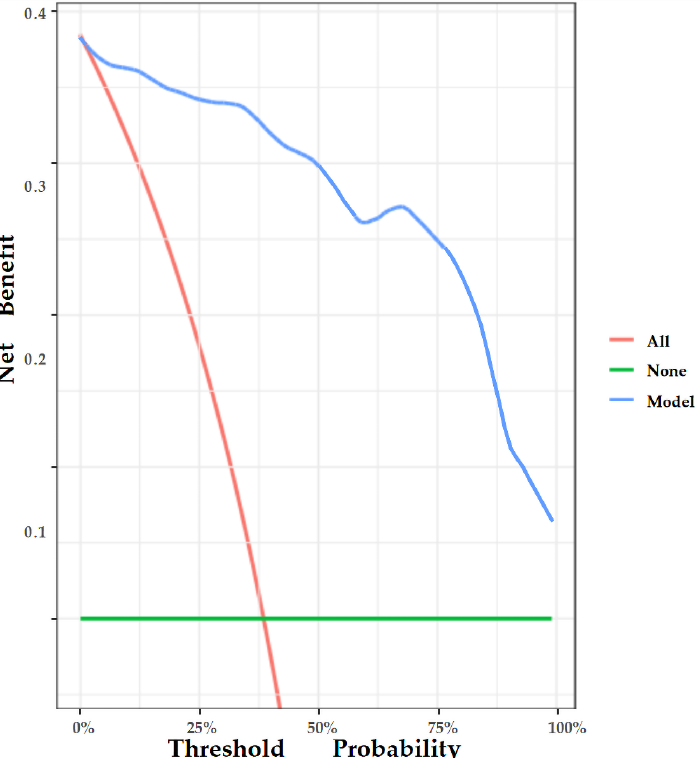
Figure 9. DCA of the nomogram. The y-axis represents the net benefit, and the x-axis represents the threshold probability. The red line represents the assumption that all patients tested positive and were all tested. The green line represents the assumption that all patients tested negative and all were not tested. The blue line represents the net benefit of our model as the threshold probability changes. It shows that our model can benefit patients with breast lesions across a considerable threshold range.